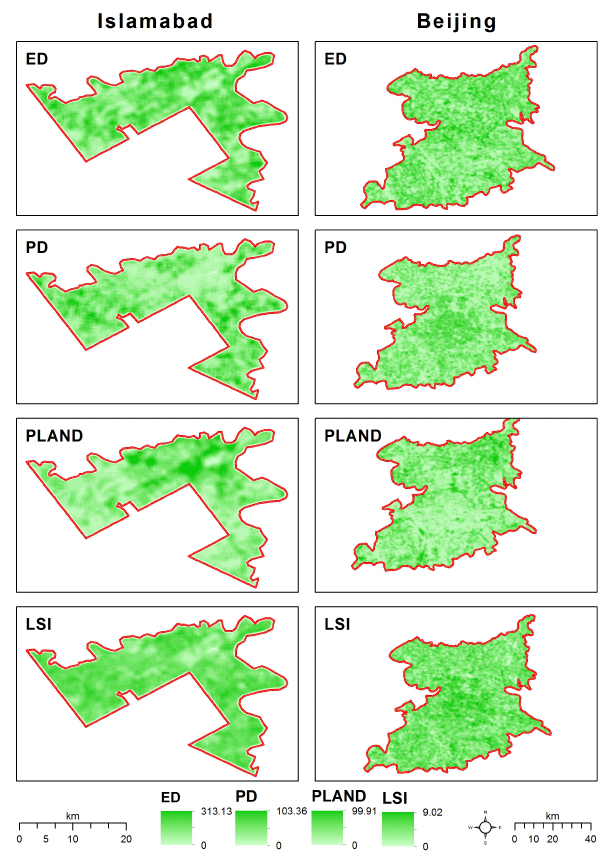
Figure 5. Landscape metrics calculated from green spaces of Beijing and